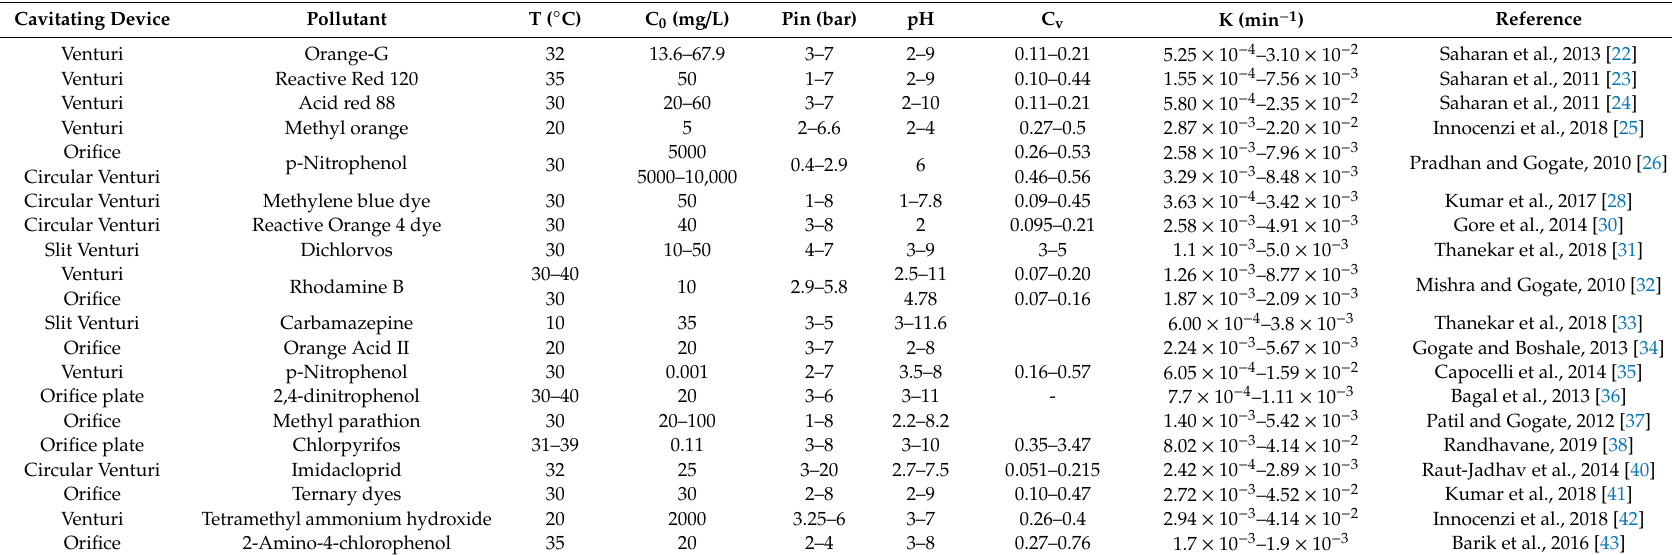
Table 1. Overview of studies considered for the aim of this